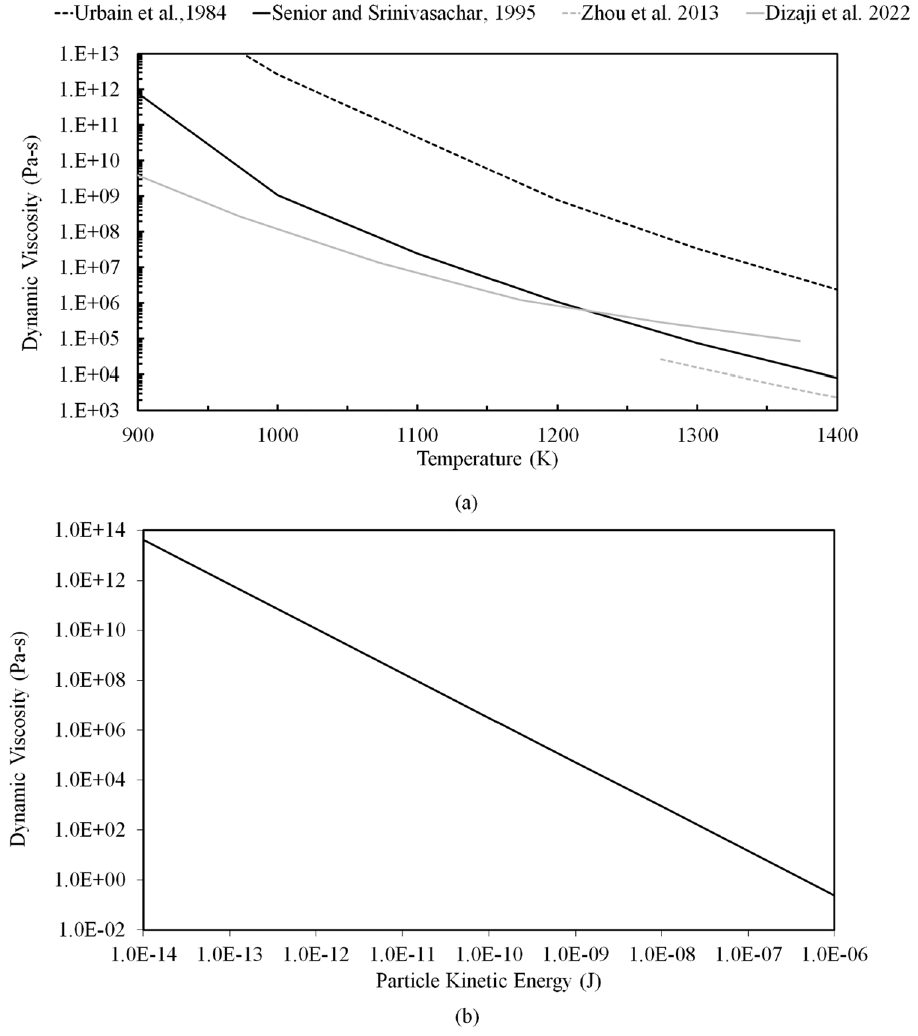
Fig. 6 a RH ash viscosity predictions employing different models (Urbain et al. 1982;